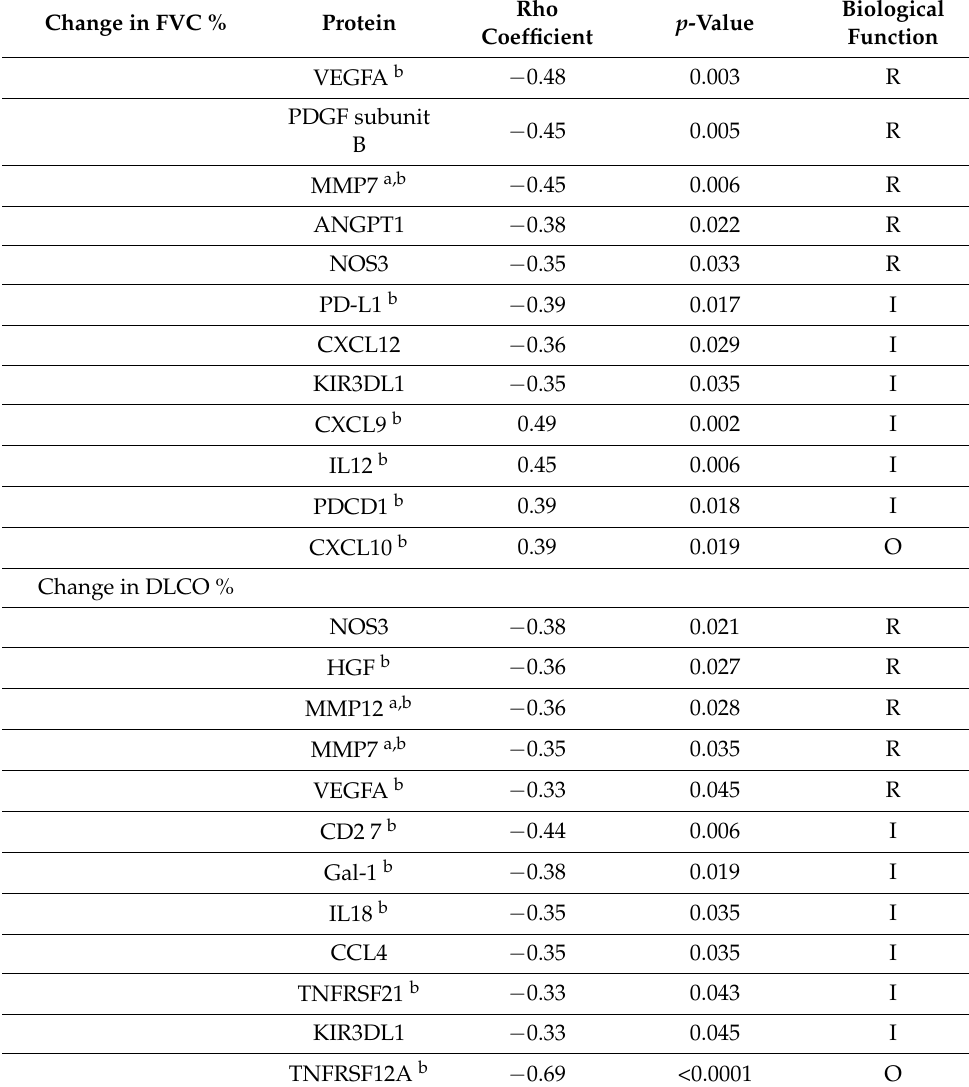
Table 6. Changes in serum proteins from patients with IPF correlates with changes in lung function. Proteins are categorized in two main biological functions, tissue remodeling (R) and inflamma- tion/chemotaxis (I) and overlapping functions (O). Correlations with changes in forced vital capacity (FVC, % predicted), diffusion capacity for carbon monoxide (DLCO, % predicted) and total lung capacity (TLC, % predicted) were calculated using Spearman rank correlation method. Proteins significantly elevated in IPF compared to controls are indicated with b . Proteins observed in ex vivo model are indicated with a . Rho p Change in FVC % Protein Coefficient